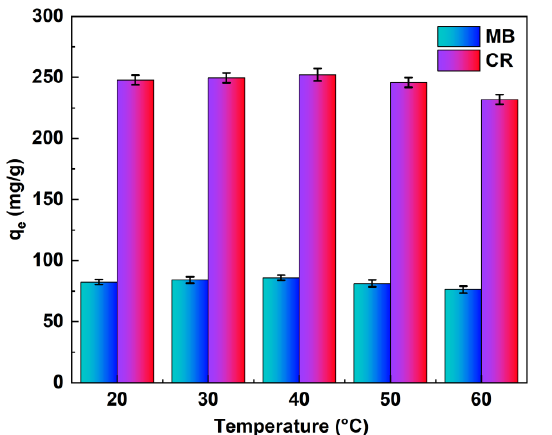
Figure 5. Effects of ambient temperature on the MB and CR adsorption capacity (pH value pH = 7, adsorption time t = 6 h).